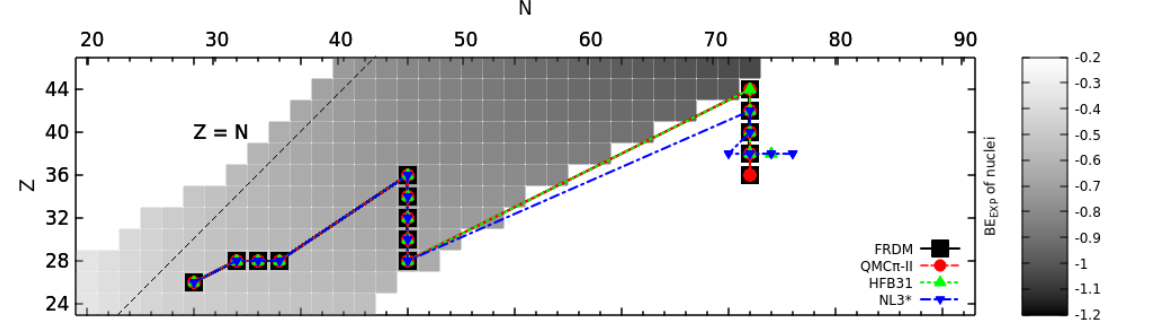
Figure 1. The sequence of nuclei appearing in the NS’s outer crust given in Z-N space. The QMC π -II model predictions are compared to several other models: FRDM [14, 15], HFB31 [16, 17] and NL3*